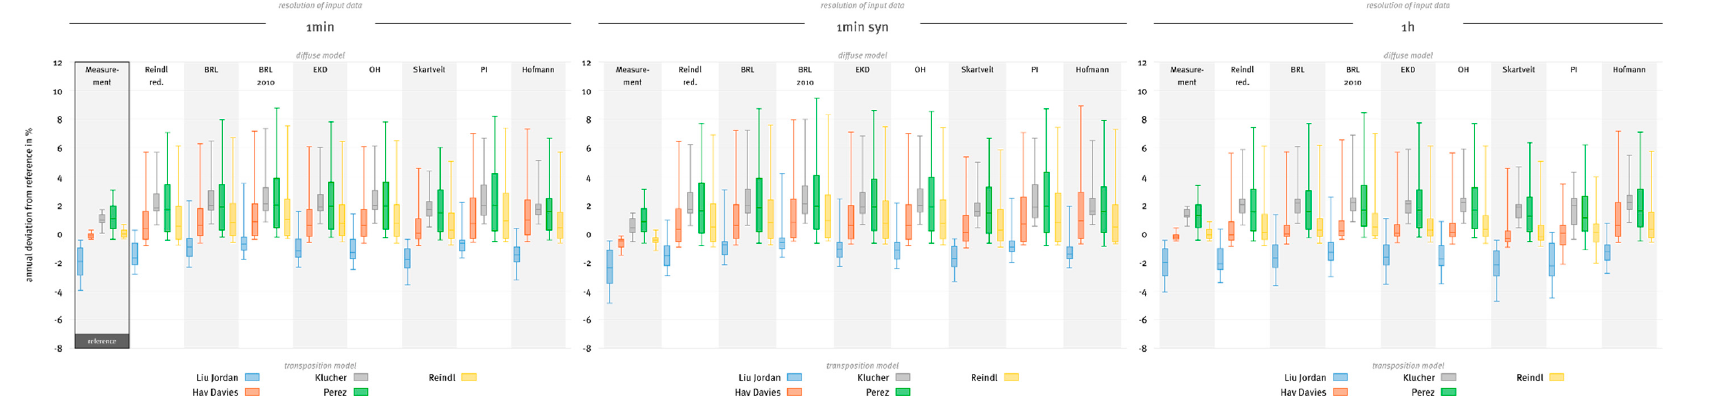
Figure A2. Same plot type as Figure A1, but for modules with optimal tilt. Corresponds to Figure 8.